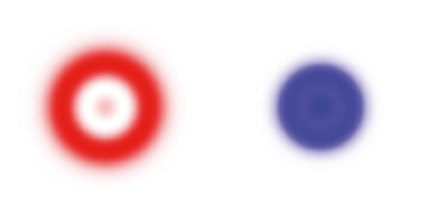
Figure 2: The magnetic field (left) and the energy density (right) of the solutions of (22a) and (22b) for the visible sector, with 𝑞, 𝑤 = 1 and 𝛽 = 20 . The darkness of the colors is directly related to the intensity of the quantities.